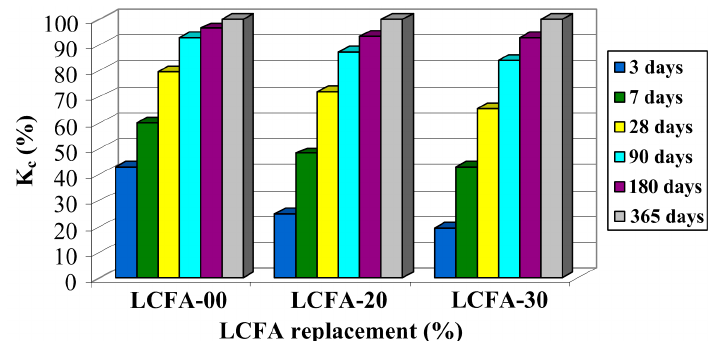
Figure 15. Relative changes of generalized fracture toughness over time.